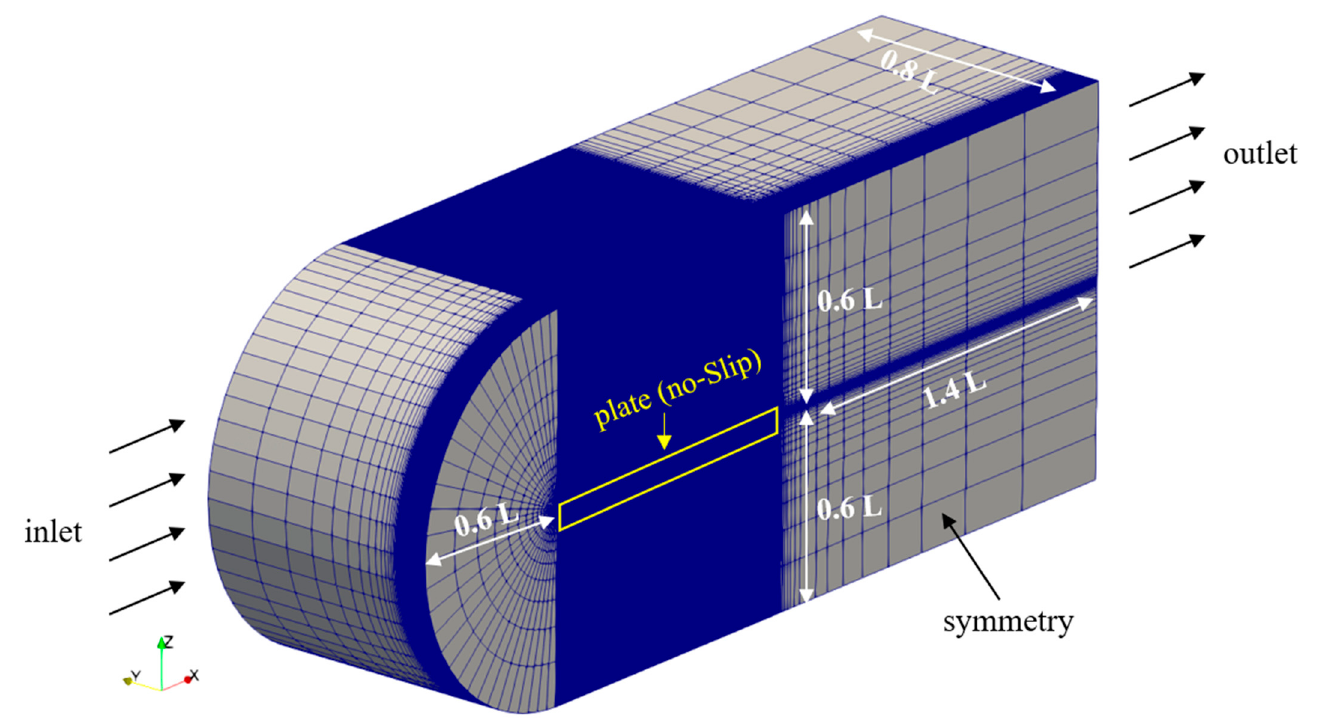
Figure 6. Domain extent, boundary conditions, and meshes.